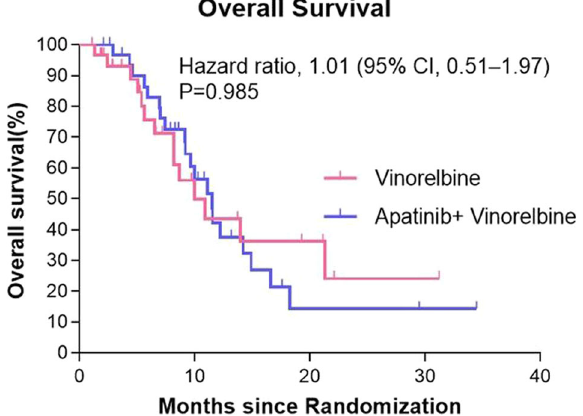
Fig. 4 Kaplan – Meier Estimates of Overall Survival among patients in the in the vinorelbine group and apatinib plus vinorelbine group.